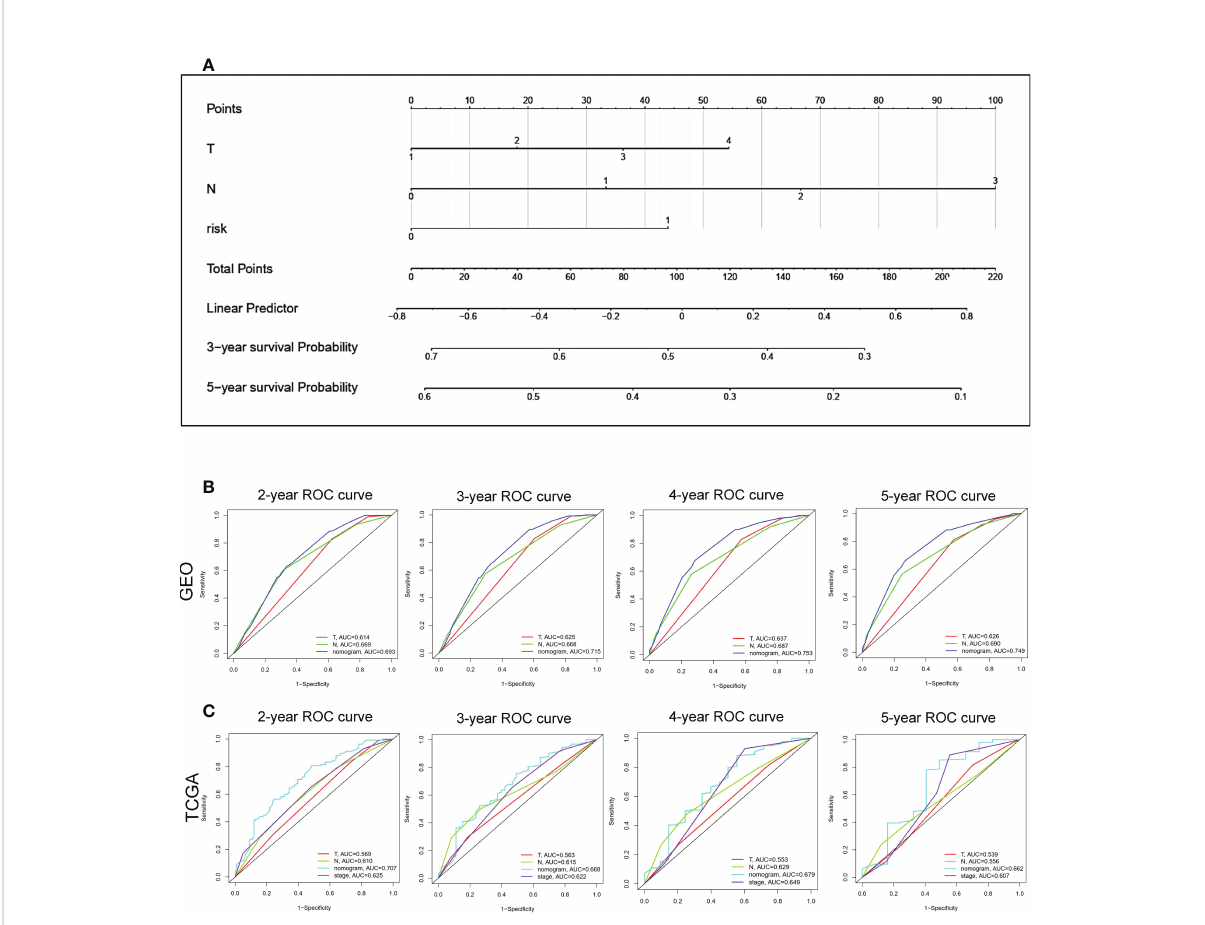
FIGURE 6 Construction of a nomogram based VM-index for prognosis prediction of GC. (A) The nomogram using T stage, N stage and VM index. For each patient, three lines are drawn upward to verify the points received from the three predictors of the nomogram. The sum of these points situates on the ‘ Total Points ’ axis. Then a line is drawn downward to assess the 3-, and 5-year overall survival of GC. (B, C) The ROC curve to evaluate the nomogram in GEO and TCGA database. Y-axis, Sensitivity; X-axis, Speci fi